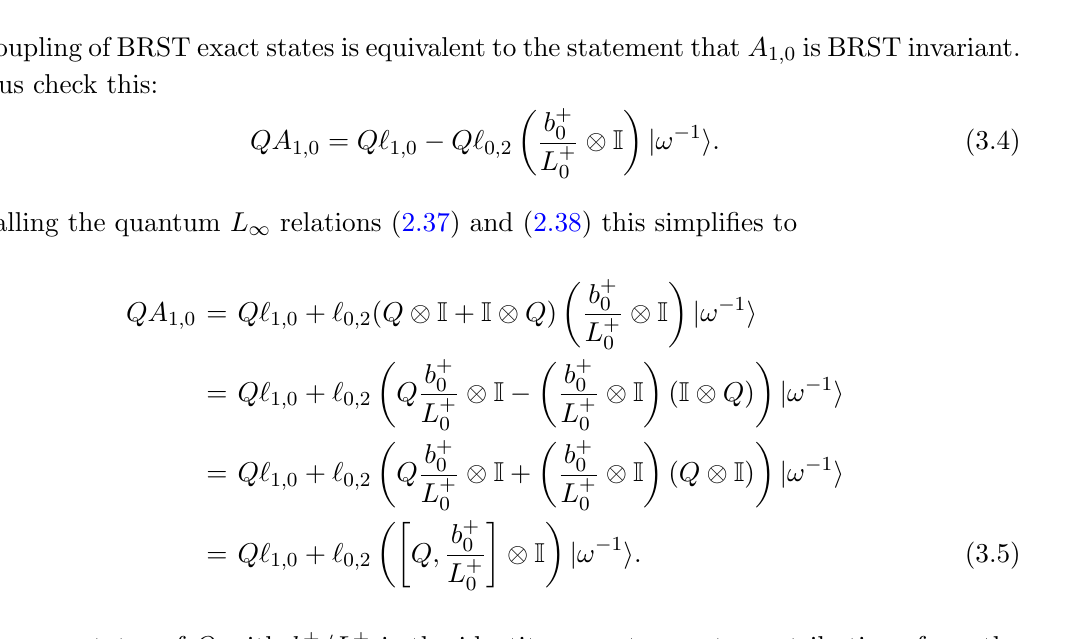
Figure 1 . The moduli space of a 1-punctured torus, as represented by the fundamental region of the standard modular parameter (cid:28) = (cid:28) 1 + i(cid:28) 2 . The subregion shaded in dark grey is associated with the tree level cubic vertex with two legs attached to a propagator tube of length s and twist angle (cid:18) . The subregion shaded light grey is associated with the fundamental 1-loop tadpole vertex. The curve @ V 1 ; 1 representing the interface between these two regions depends in detail on the de(cid:12)nition of the tree level cubic vertex, and part of our task will be to determine this